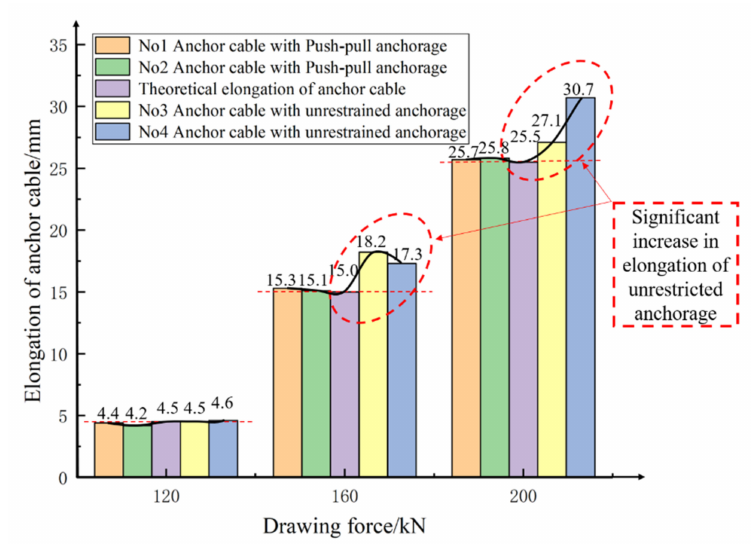
Figure 18. Pull-out test results for anchor cables.